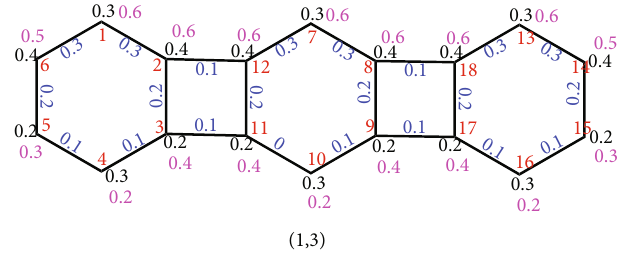
Figure 2: (1, 3) unit of fuzzy graph of phenylene. Table 1: Vertex count for fuzzy graph of linear phenylene. Vertex w.r.t. vertex weight